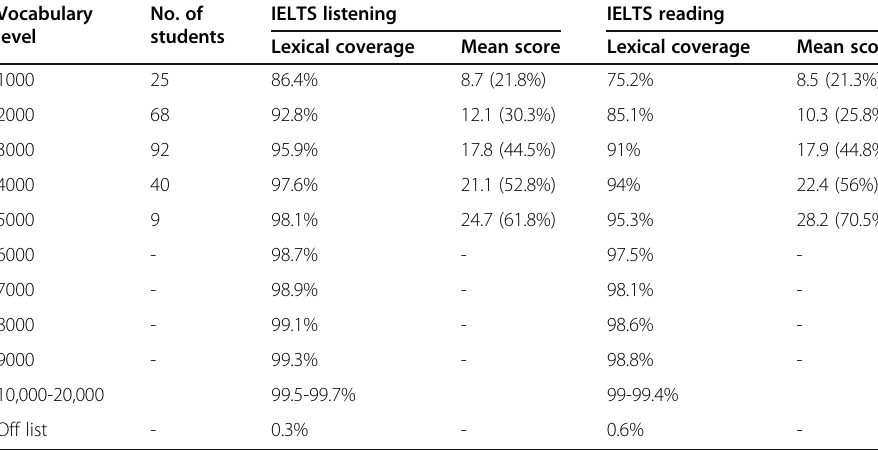
Table 6 Relationship between the UVLT score, lexical coverage, listening and reading comprehension Vocabulary